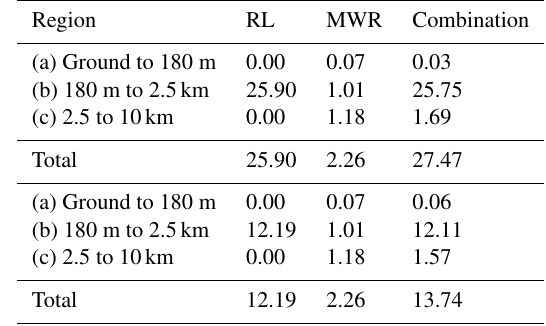
Table 1. Degrees of freedom for signal comparison for absolute hu- midity. Average over 636 profiles. The atmosphere is separated into three regions according to lidar availability. The DOF are presented for three cases: only RL, only MWR and the combination of both instruments. In the upper part, no increment on the RL uncertainty has been considered. In the bottom part, the RL uncertainty has been multiplied by a factor of 4.